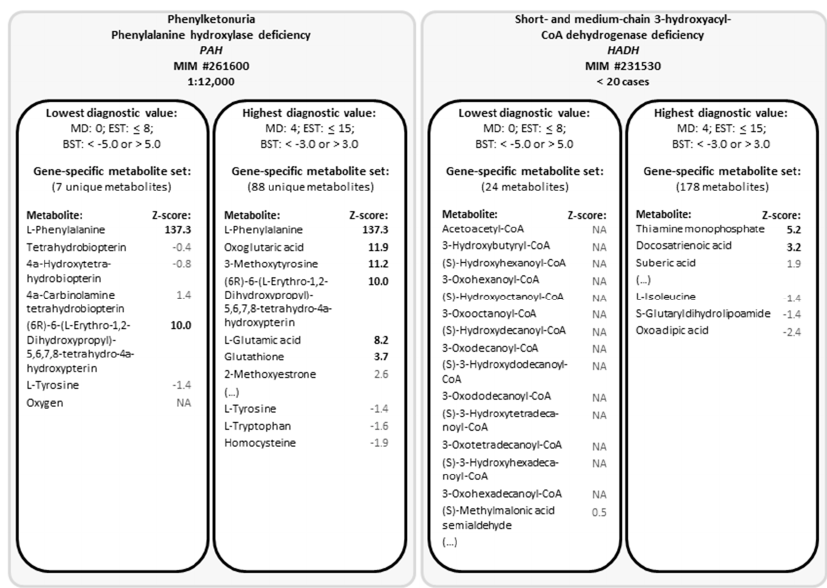
Figure 3. Gene-specific metabolite sets for phenylketonuria and short- and medium-chain 3-hydroxyacyl-CoA dehydrogenase deficiency for the parameter combination with the lowest and with the highest diagnostic value. Abbreviations: BST, biochemical stringency threshold; EST, extension stringency threshold; MD, maximum distance to the primary reaction; MIM, (online) Mendelian Inheritance in Man (number); NA, not